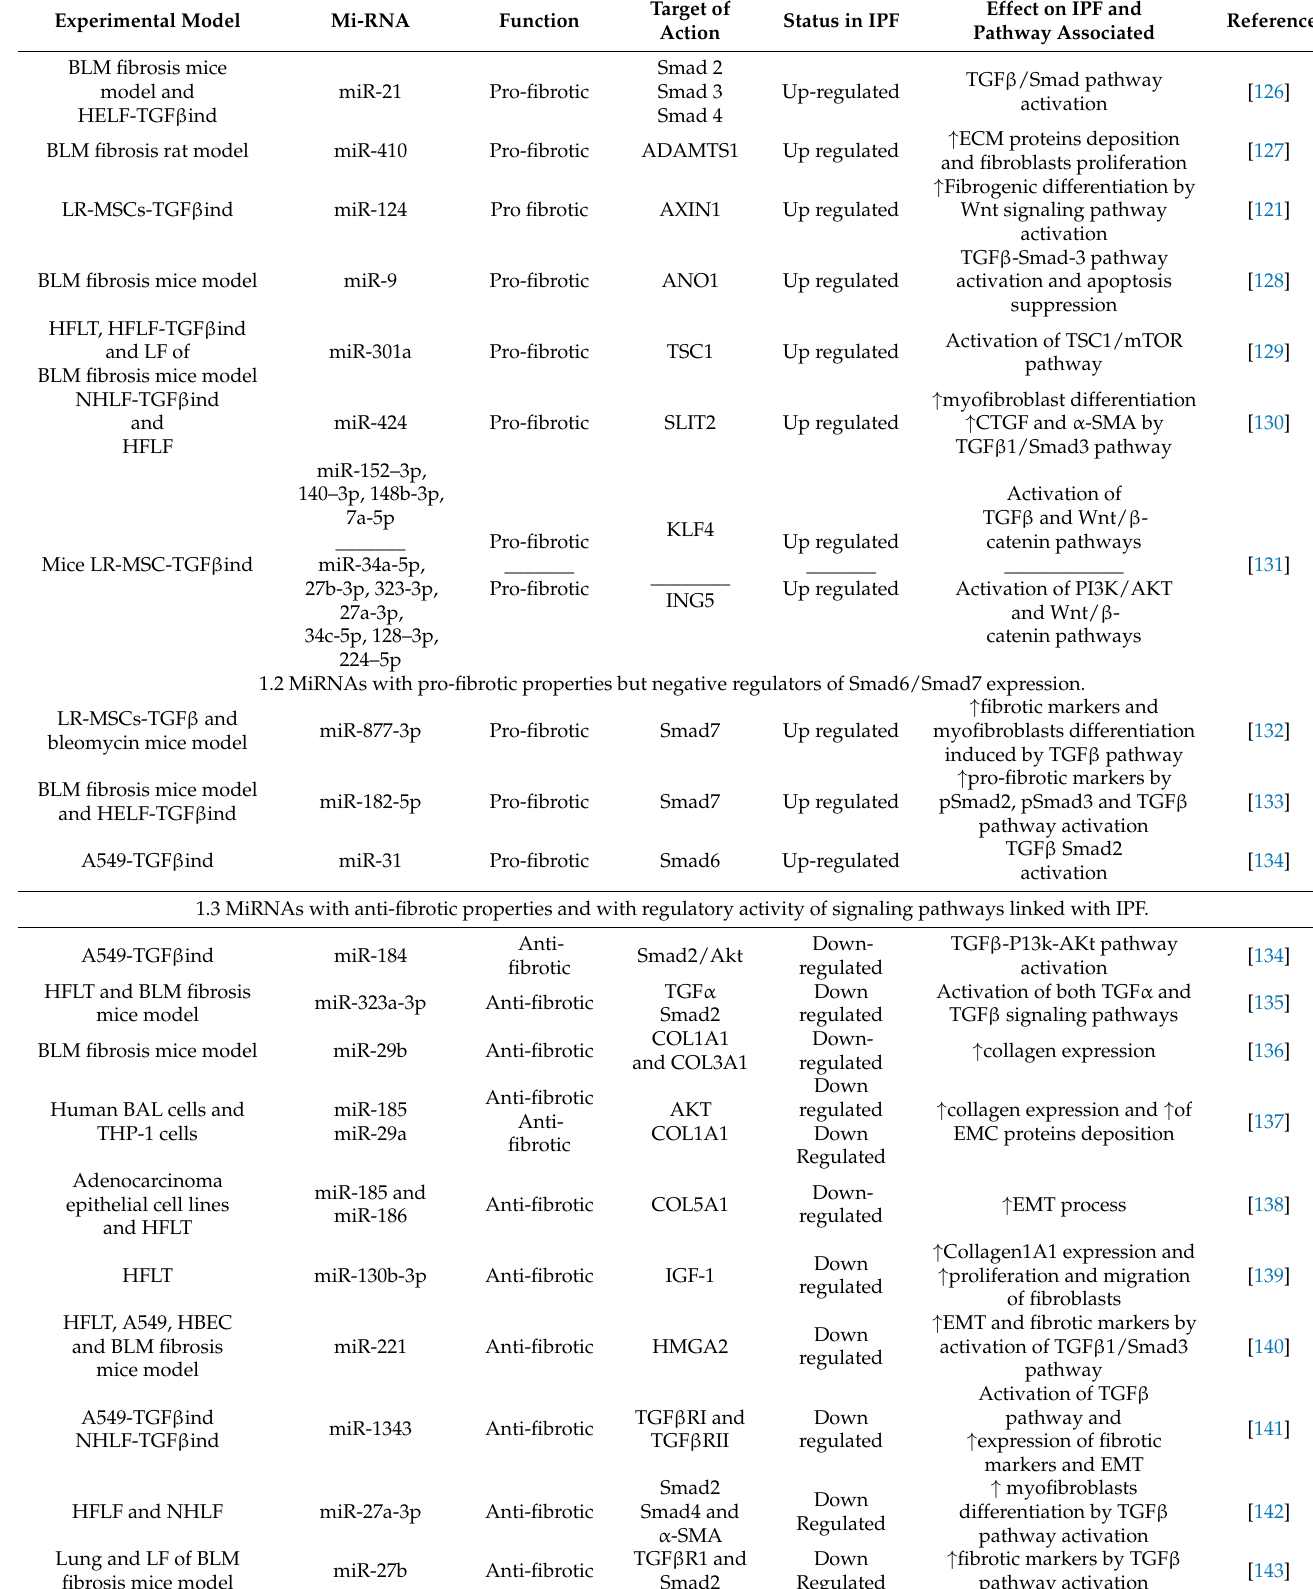
Table 1. MiRNAs associated with the pathogenesis of Idiopathic Pulmonary Fibrosis